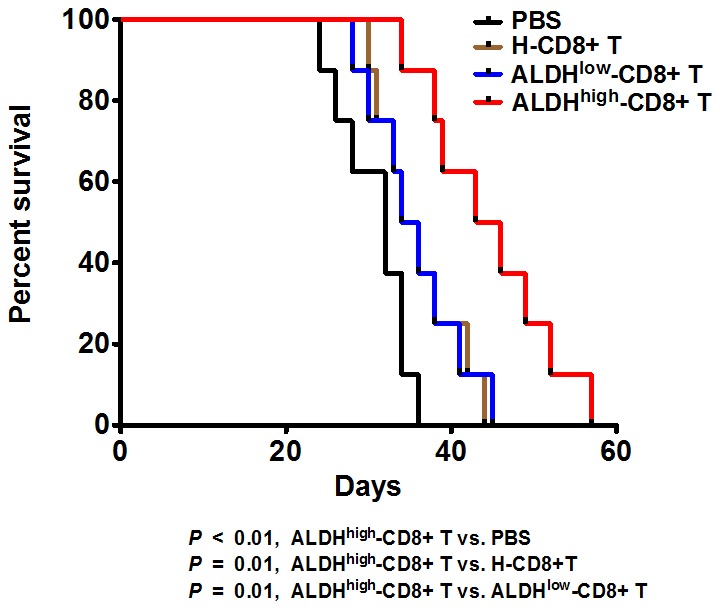
ALDHhigh-CD8+ T treatment prolongs the overall survival of the tumor-bearing mice.The mice treated with ALDHhigh-CD8+ T cells survived much longer than the mice treated with PBS, H-CD8+ T, or ALDHlow-CD8+ T cells.